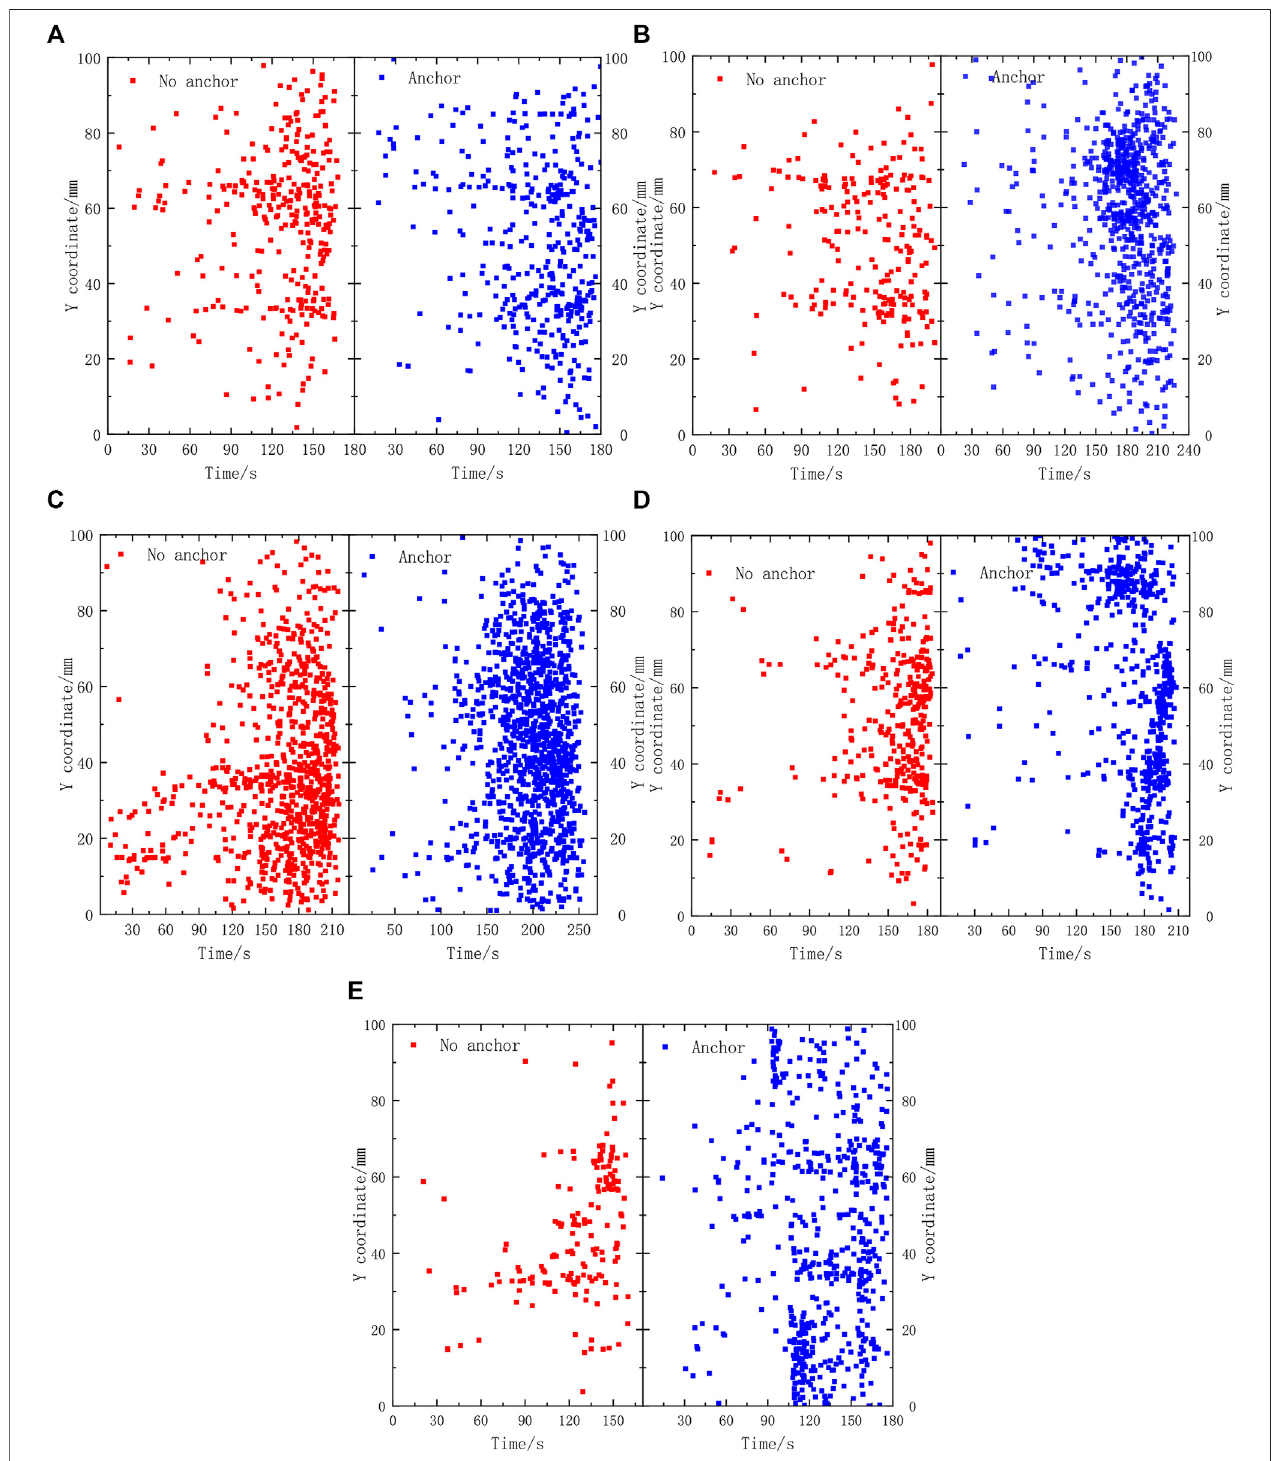
FIGURE 14 | Distribution of acoustic emission event height with time in layered sandstone: (A) 0 ° sandstone; (B) 30 ° sandstone; (C) 45 ° sandstone; (D) 60 ° sandstone; (E) 90 ° sandstone.